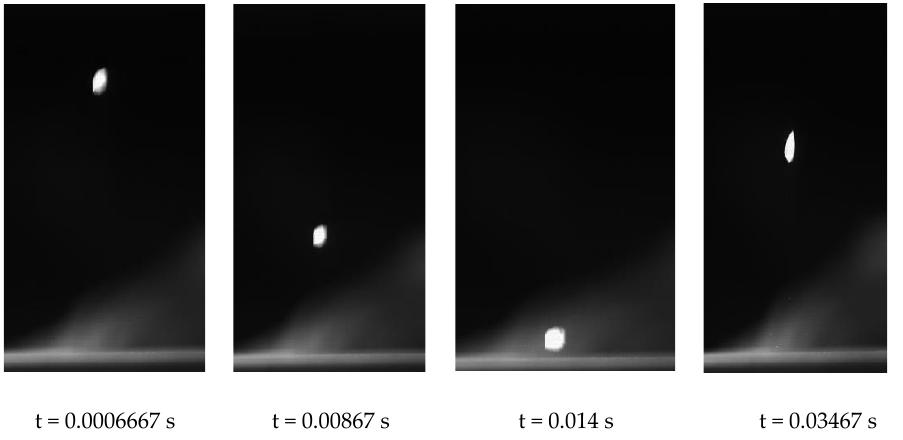
Figure 7. Grain falling collision process.